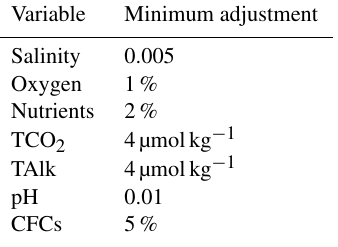
Table 3. Initial minimum adjustment limits. These limits represent the minimum bias that can be confidently established relative to the measurement precision for the variables and cruises considered. Note that these limits are not uncertainties but rather a priori esti- mates of global inter-cruise consistency in the data